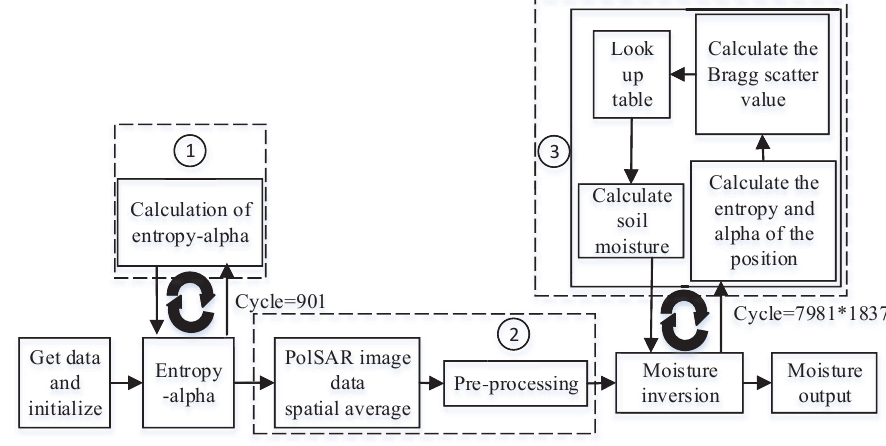
Figure 4. X-Bragg algorithm